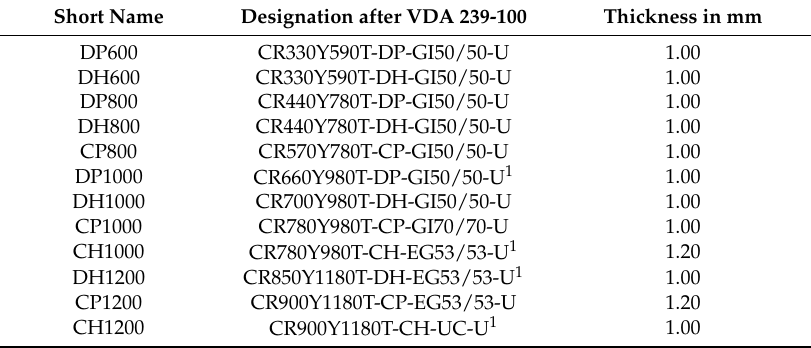
Table A1. Investigated materials.